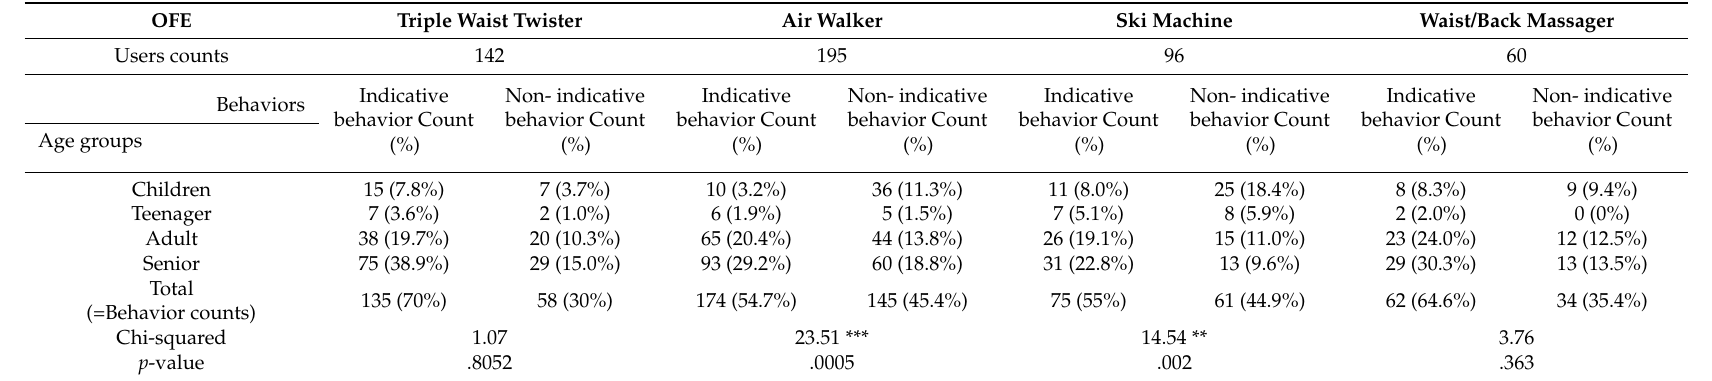
Table 1. Pearson’s chi-square test for the age group and non (indicative) behavior for each type of equipment.